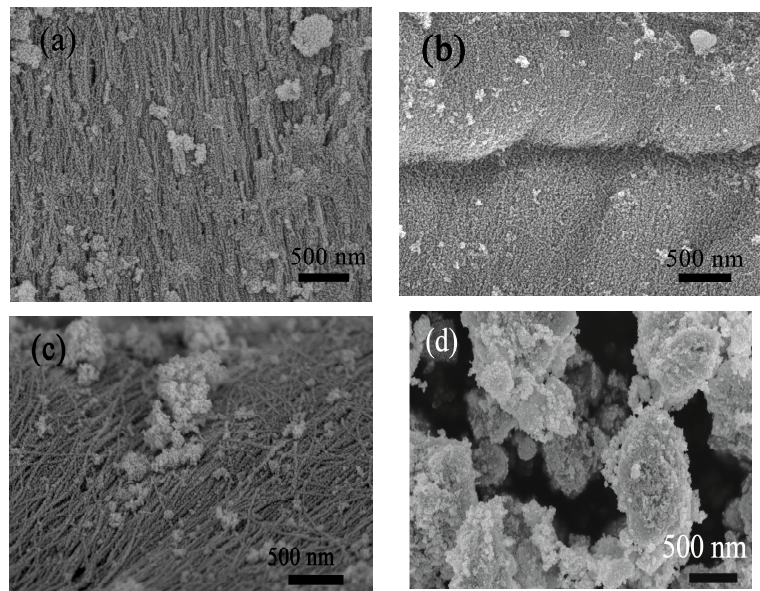
Figure 2. Field-emission scanning electron microscopy (FESEM) images of as-prepared 5 mol% Pd-functionalized SnO 2 nanofibers containing shaddock peels before ( a ) and after calcination ( b ), respectively; ( c ) FESEM image of 3 mol % Pd-functionalized SnO 2 nanofibers after calcination; and